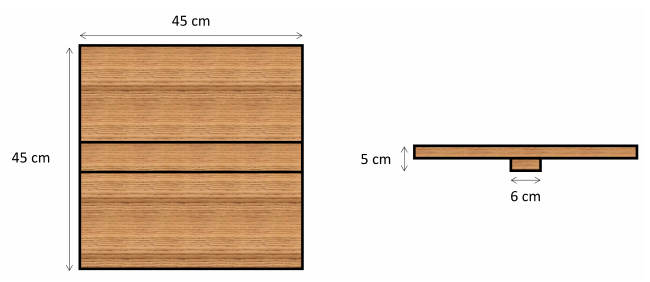
Figure 4. The wooden board: bottom and lateral